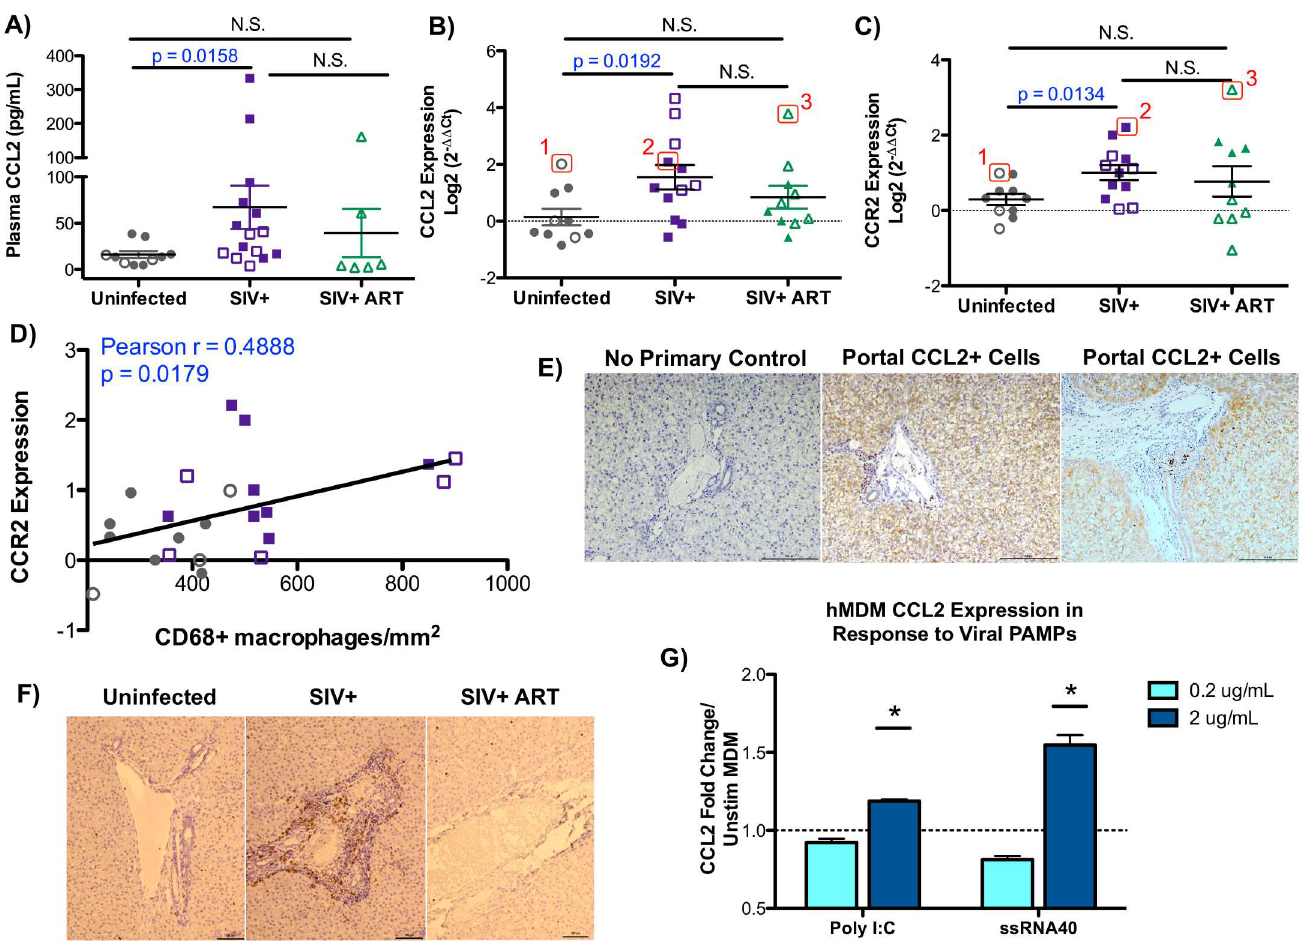
Fig 2. The CCL2-CCR2 pathway is associated with liver monocyte/macrophage infiltration. A) Levels of CCL2 (MCP-1) in the blood were determined by Luminex analysis. Data are graphed as the mean ± SEM. Adult (open symbols) and infant (closed symbols) macaques are denoted in each graph. B-C) Hepatic expression of CCL2 (B) and its receptor, CCR2, (C) were evaluated by quantitative PCR using cDNA prepared from RNA isolated from the liver of each animal. Data are graphed as log2 transformed relative expression levels determined by the comparative threshold method. Numbered macaques (1, 2, and 3) denote CCL2 and CCR2 expression levels for these three individual macaques between panels 2B and 2C. D) Correlation between the expression of CCR2 in the liver (y-axis) and the number of liver macrophages (x-axis) in uninfected (gray points) and SIV-infected (purple points) macaques was evaluated by Pearson Correlation analysis. E) Immunostaining for CCL2 in the livers of SIV-infected macaques depicting portal regions (100X magnification, scale bar = 100 um). A no primary CCL2 antibody negative control was included to show specific staining (100X magnification, scale bar = 100 um). F) Immunohistochemical staining of recently infiltrated Mac387-positive monocyte/macrophages (brown cells) localized in the portal regions of the liver for uninfected, SIV+, and SIV+ ART macaques (100X magnification, scale bar = 100 um). G) Human monocyte-derived macrophages were stimulated with poly I:C or ssRNA40 at 0.2 and 2 ug/mL for 12 hours in duplicate. Relative expression of CCL2 was assessed by qRT-PCR comparing poly I:C and ssRNA40 stimulated cells to control (unstimulated) monocyte-derived macrophages. Data are graphed as the mean fold change in CCL2 expression ± SEM. Statistical significance was determined using a Mann Whitney T test comparing technical replicates of each condition to unstimulated cells with p (cid:20) 0.05 denoted as (cid:3)